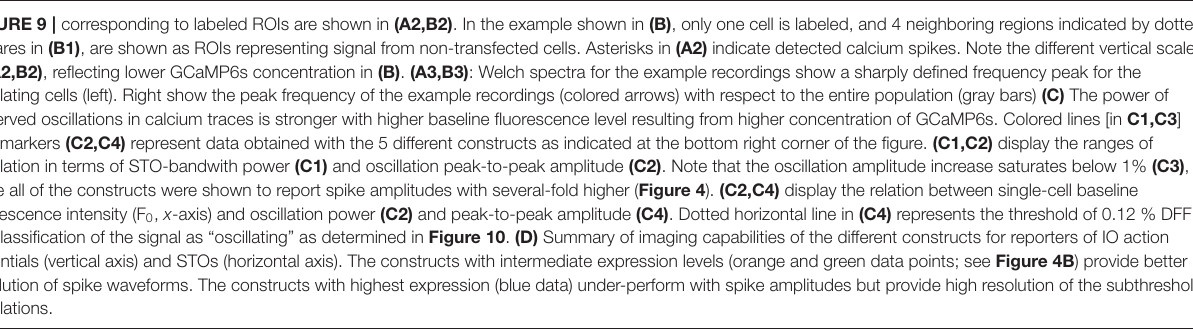
FIGURE 9 | corresponding to labeled ROIs are shown in (A2,B2) . In the example shown in (B) , only one cell is labeled, and 4 neighboring regions indicated by dotted squares in (B1) , are shown as ROIs representing signal from non-transfected cells. Asterisks in (A2) indicate detected calcium spikes. Note the different vertical scales in (A2,B2) , reflecting lower GCaMP6s concentration in (B) . (A3,B3) : Welch spectra for the example recordings show a sharply defined frequency peak for the oscillating cells (left). Right show the peak frequency of the example recordings (colored arrows) with respect to the entire population (gray bars) (C) The power of observed oscillations in calcium traces is stronger with higher baseline fluorescence level resulting from higher concentration of GCaMP6s. Colored lines [in C1,C3 ] and markers (C2,C4) represent data obtained with the 5 different constructs as indicated at the bottom right corner of the figure. (C1,C2) display the ranges of oscillation in terms of STO-bandwith power (C1) and oscillation peak-to-peak amplitude (C2) . Note that the oscillation amplitude increase saturates below 1% (C3) , while all of the constructs were shown to report spike amplitudes with several-fold higher ( Figure 4 ). (C2,C4) display the relation between single-cell baseline fluorescence intensity (F 0 , x -axis) and oscillation power (C2) and peak-to-peak amplitude (C4) . Dotted horizontal line in (C4) represents the threshold of 0.12 % DFF for classification of the signal as “oscillating” as determined in Figure 10 . (D) Summary of imaging capabilities of the different constructs for reporters of IO action potentials (vertical axis) and STOs (horizontal axis). The constructs with intermediate expression levels (orange and green data points; see Figure 4B ) provide better resolution of spike waveforms. The constructs with highest expression (blue data) under-perform with spike amplitudes but provide high resolution of the subthreshold